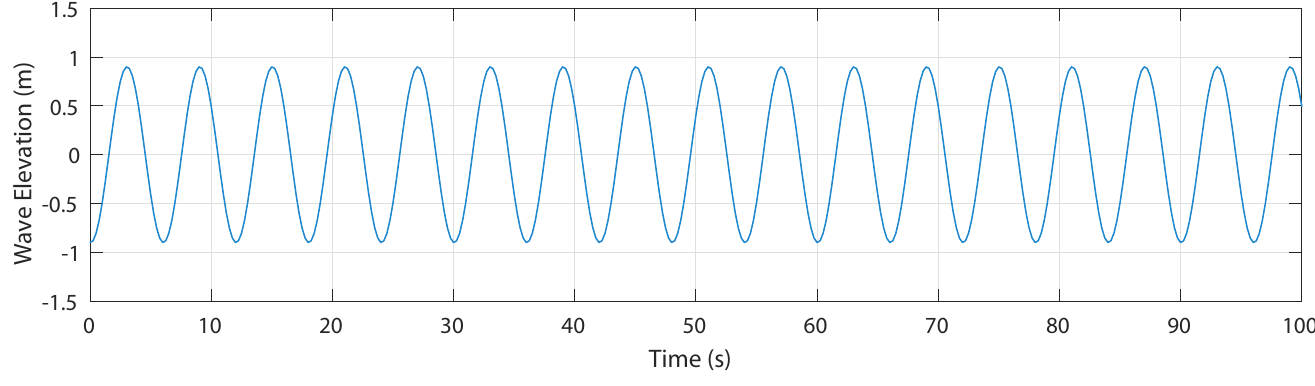
Figure 7. Wave elevation